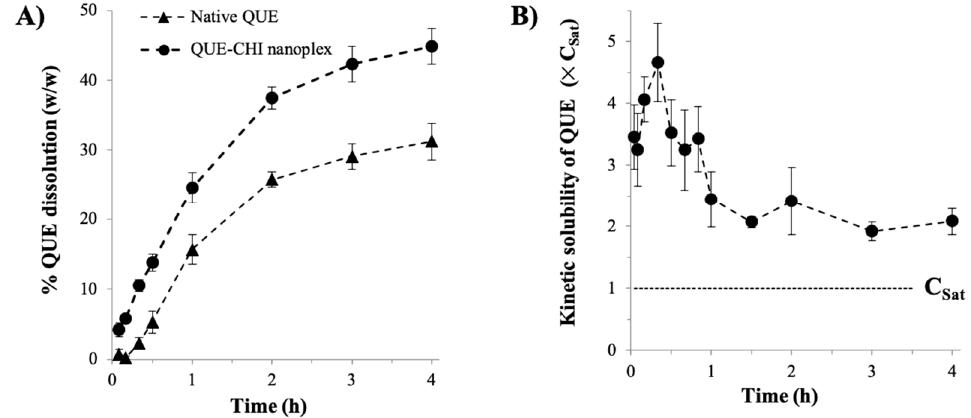
Figure 6. ( A ) dissolution of the QUE–CHI nanoplex versus the native QUE; ( B ) QUE kinetic solubility.